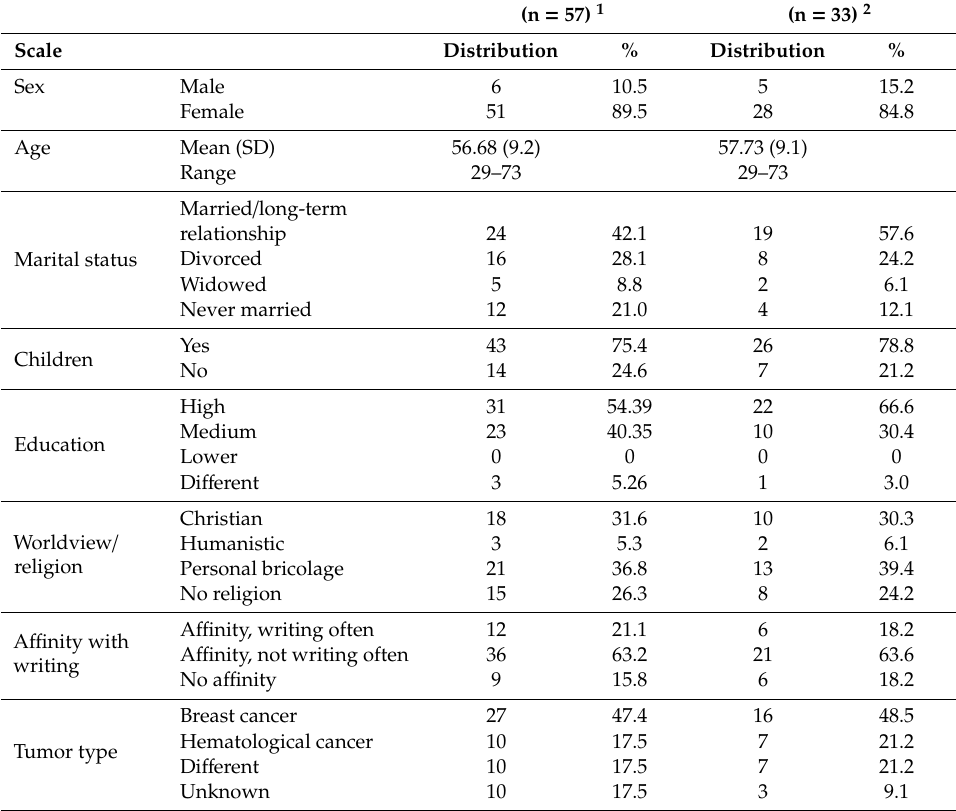
1 Demographic characteristics at baseline (T0). 2 Demographic characteristics of qualitative interview